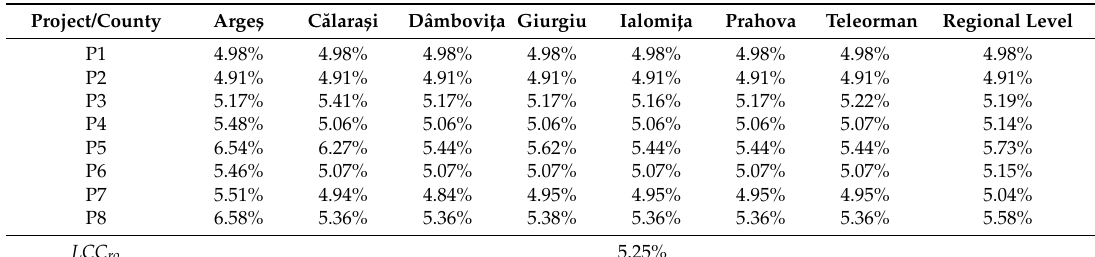
Table 6. LCC variation at the regional level for the maximum scenario (%) in the case of the increase of the maintenance cost by